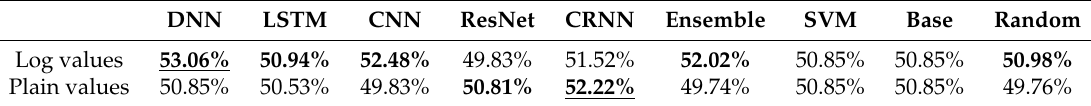
Table 8. Effect of using log values on classification (accuracy). The sequence size is m = 50. The sequential partitioning and the first value-based normalization were used. DNN LSTM CNN ResNet CRNN Ensemble SVM Base